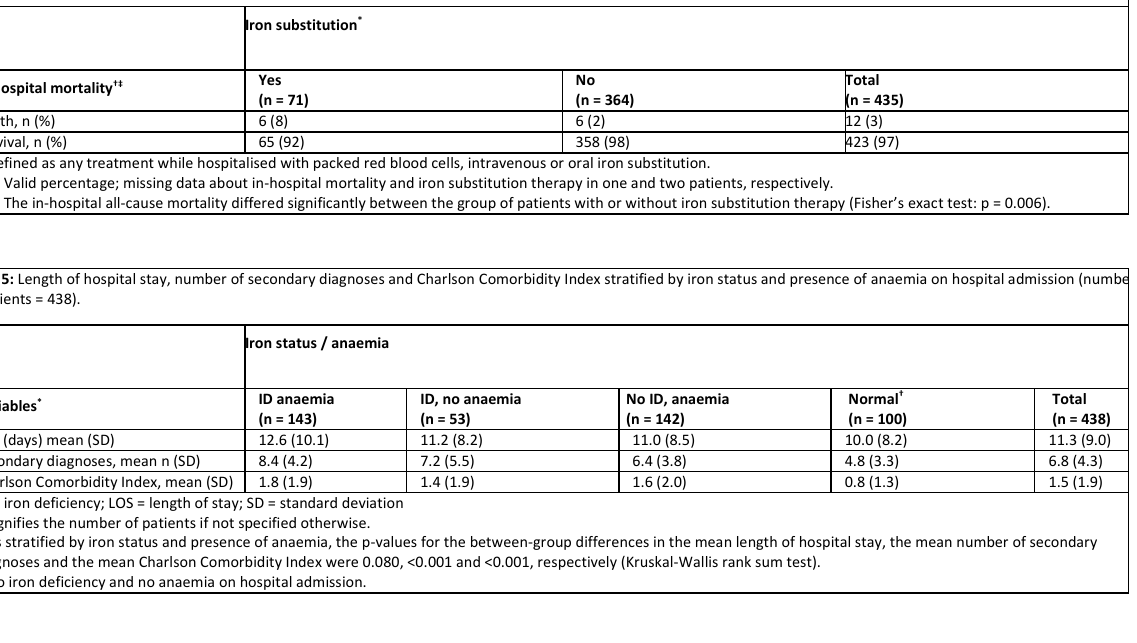
Table 4: In-hospital all-cause mortality stratified by iron substitution (number of patients = 435). Iron substitution *